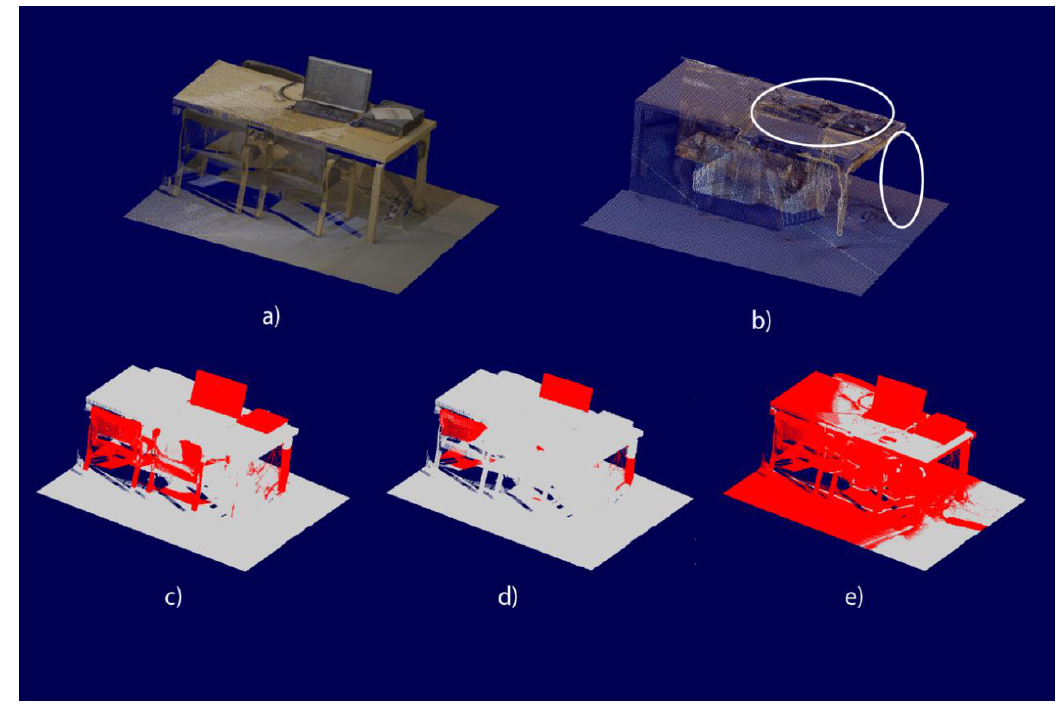
Figure 11. The RGB-colored RTC360 ( a ) and Theta V ( b ) point clouds of the hall 101 segment, with the clearest visual differences noted; the points on the RTC360 point cloud with a distance to the Theta V point cloud larger than the 90th percentile deviations ( c ), 99th percentile deviations ( d ), and 1 cm ( e ), with points exceeding the threshold shown in red. Significant completeness issues can be seen, particularly in the 99th percentile deviations.